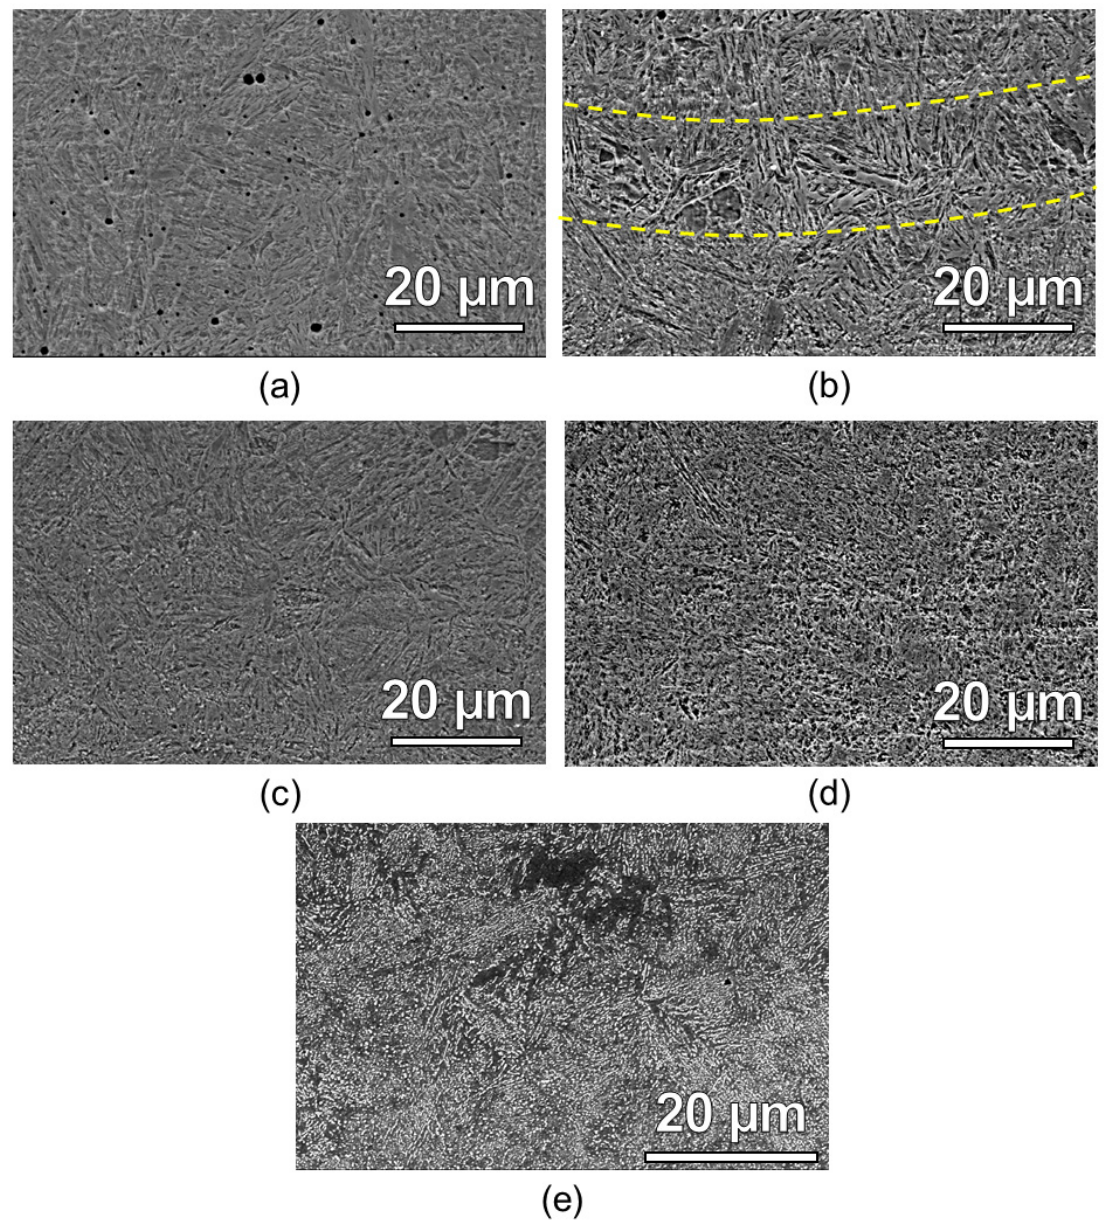
Figure 7. SEM micrographs at different position: ( a ) LMZ, shown as ‘a’ in Figure 5; ( b ) transition zone, shown as ‘b’ in Figure 5; ( c ) LHZ, shown as ‘c’ in Figure 5; ( d ) HAZ, shown as ‘d’ in Figure 5; and ( e ) base microstructure. The specimen was etched with 2% nital solution for 5 s before observation under SEM.